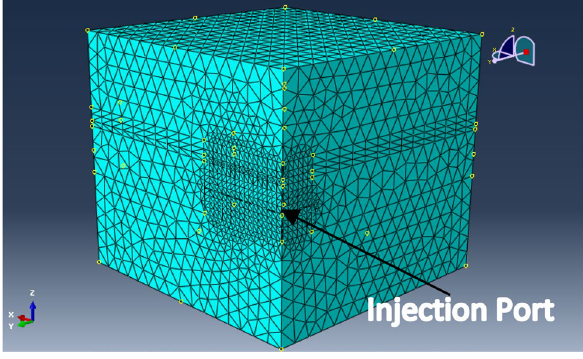
Fig. 1 Meshing of the finite elements for hydraulic fracturing